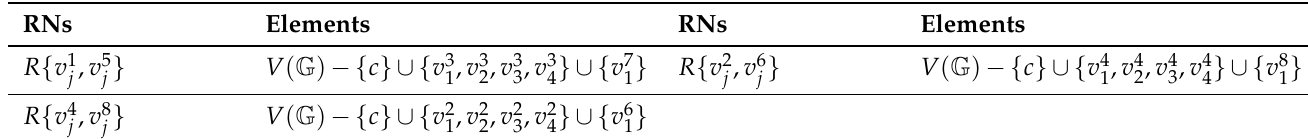
Table 15. RNs ´ R u for 49 ≤ u ≤ 60 and 2 ≤ j ≤ 4.